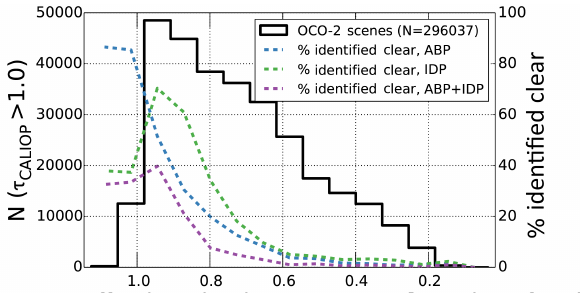
Figure 8. Histogram of the number of OCO-2 soundings with CALIOP optical depth > 1 (solid trace against the left ordinate) and percent of soundings (dotted traces against the right ordinate) iden- tified as clear versus the CALIOP effective cloud top pressure (de- fined in the text) for the May nadir-land viewing data. The results for the combined ABP + IDP are shown in pink, the ABP only in blue and IDP only in